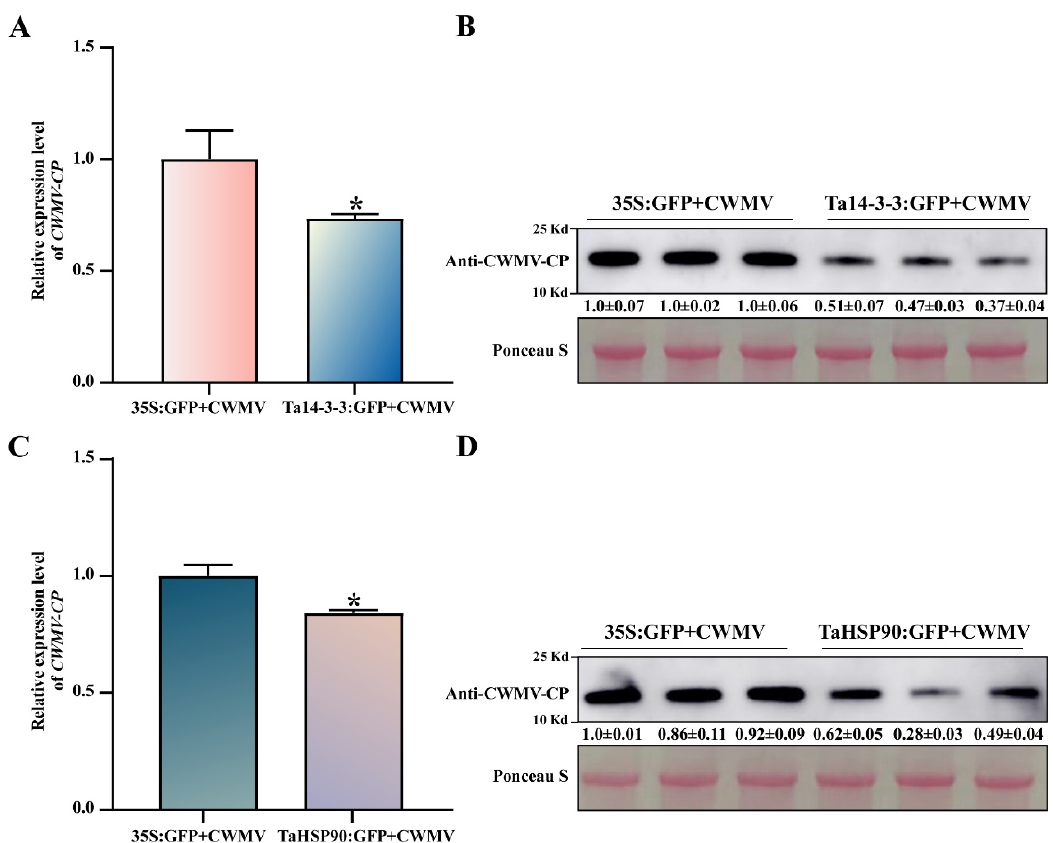
Figure 7. Effects of Ta14-3-3 and TaHSP90 expression on CWMV infection in Nicotiana benthamiana . Accumulation of CWMV CP was detected in the Ta14-3-3 and TaHSP90 transient overexpression material through qRT-PCR ( A , C ) and Western blotting ( B , D ), and 35S:GFP acted as the negative control. * indicates a significant difference between the two treatments ( p <0.05). Each treatment was repeated thrice, and Ponceau S was used to measure protein content in different